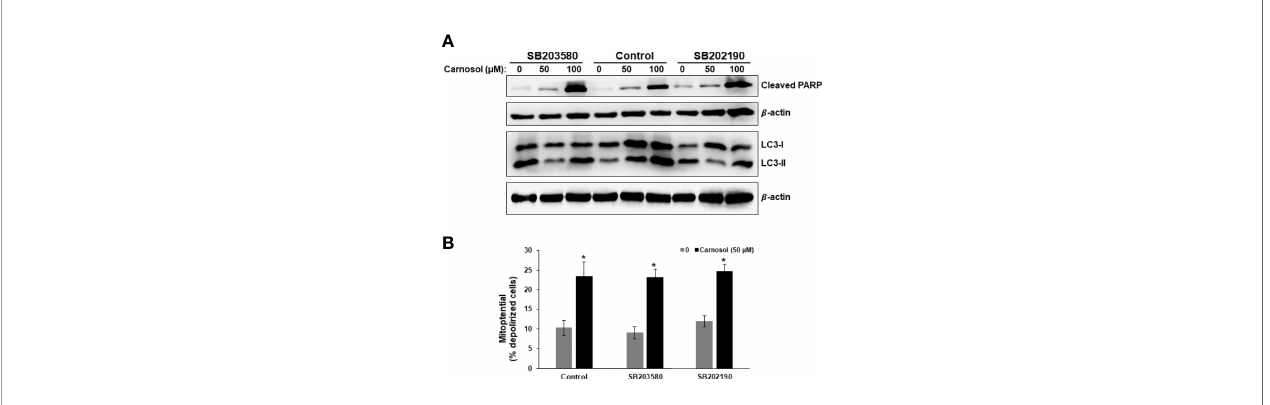
FIGURE 6 | p38-dependent induction of autophagy in carnosol-treated MDA-Mb-231 cells. (A) Inhibition of p38 blocks carnosol-induced autophagy in MDA-MB- 231 cells. Cells were pre-treated with the p38 inhibitors (SB203580 or SB202190) before adding carnosol (50and 100 µM) for 24 hours. Whole cell lysates were analyzed by Western blot for the marker of autophagy (LC3II) and apoptosis (cleaved PARP). (B) Inhibition of p38 activation failed to restore the carnosol-induced loss of mitochondrial membrane potential in MDA-MB-231 cells. Mitochondrial membrane potential (MMP) of cells pre-treated with p38 inhibitor, prior to the addition of carnosol for 24 hours, was assessed with the Muse Cell Analyzer using the Muse MitoPotential kit as described in Materials and Methods. Data represent the mean ± SEM of at least 3 independent experiments. Student ’ s t-test was performed to determine the signi fi cance